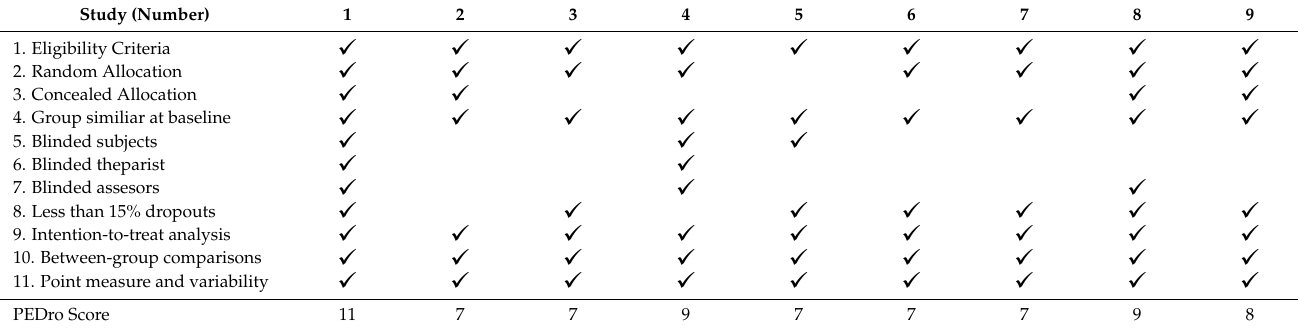
Table 3. Other variables related to mobility and secondary aspects of the psycho-social field were evaluated in the included articles.